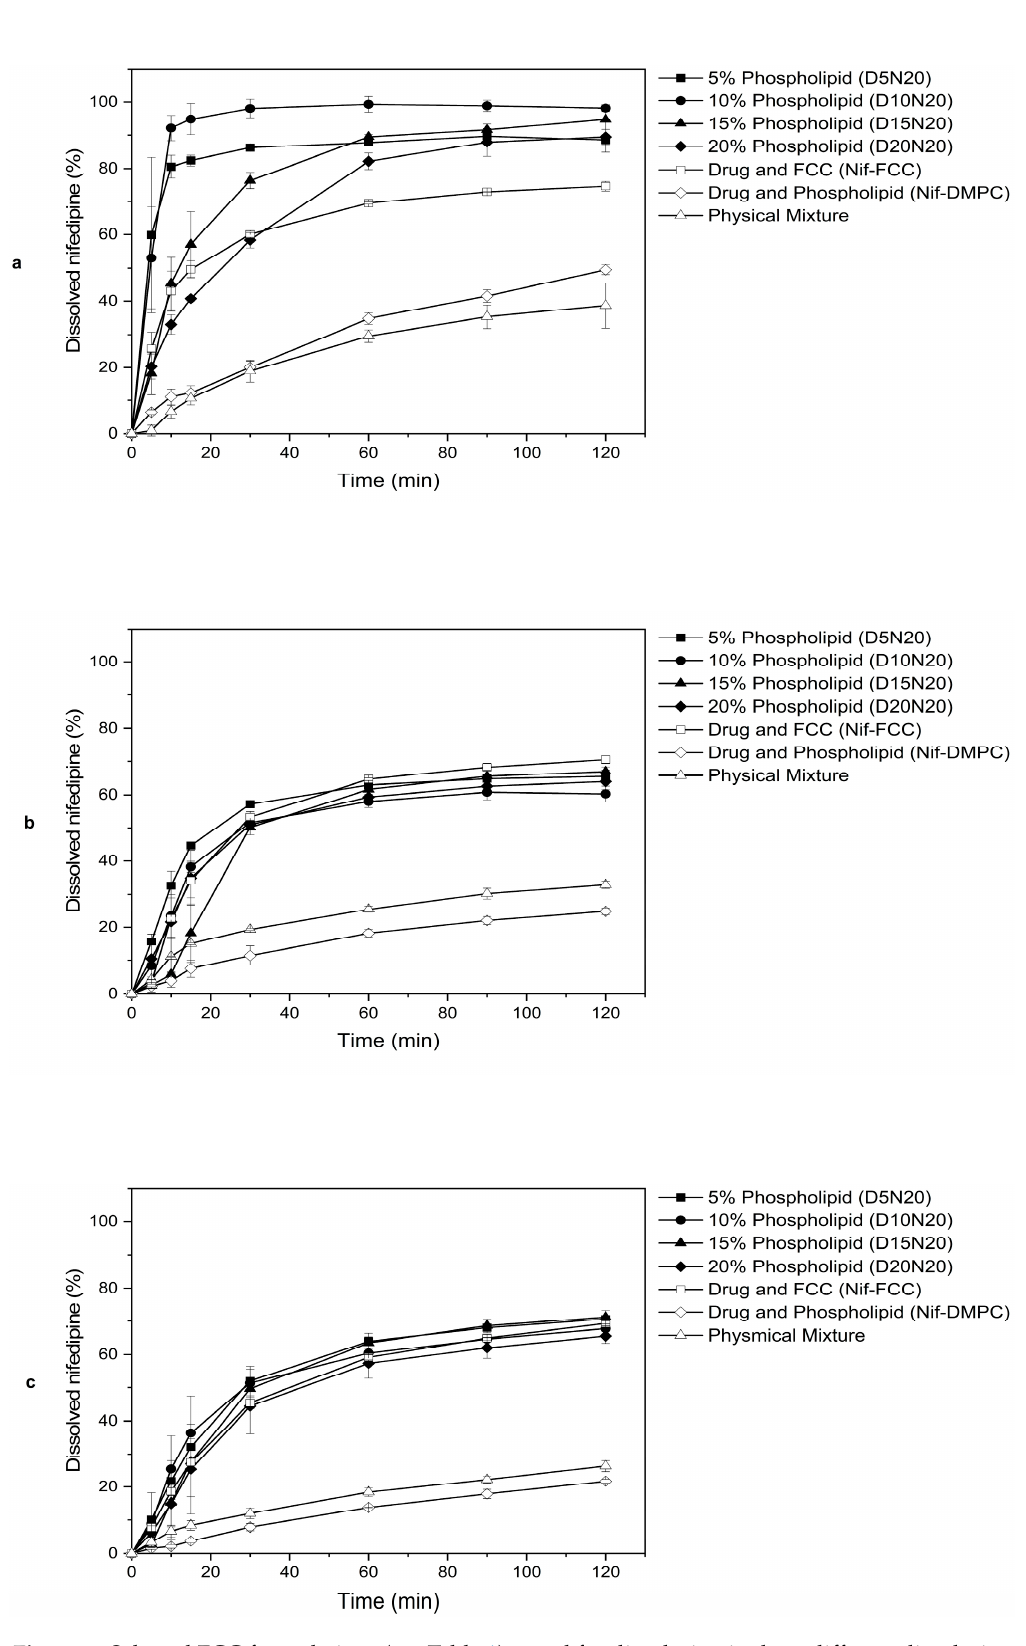
1 Figure 3. Selected FCC formulations (see Table 1) tested for dissolution in three di ff erent dissolution media: ( a ) SGF without enzyme, ( b ) fasted state-simulated intestinal fluid (FaSSIF), and ( c ) phosphate bu ff er, pH 6.8. Solid symbols represent formulations containing an increasing amount of phospholipid. Open symbols represent control formulations. Values are mean ± SD of n = 2 or 3